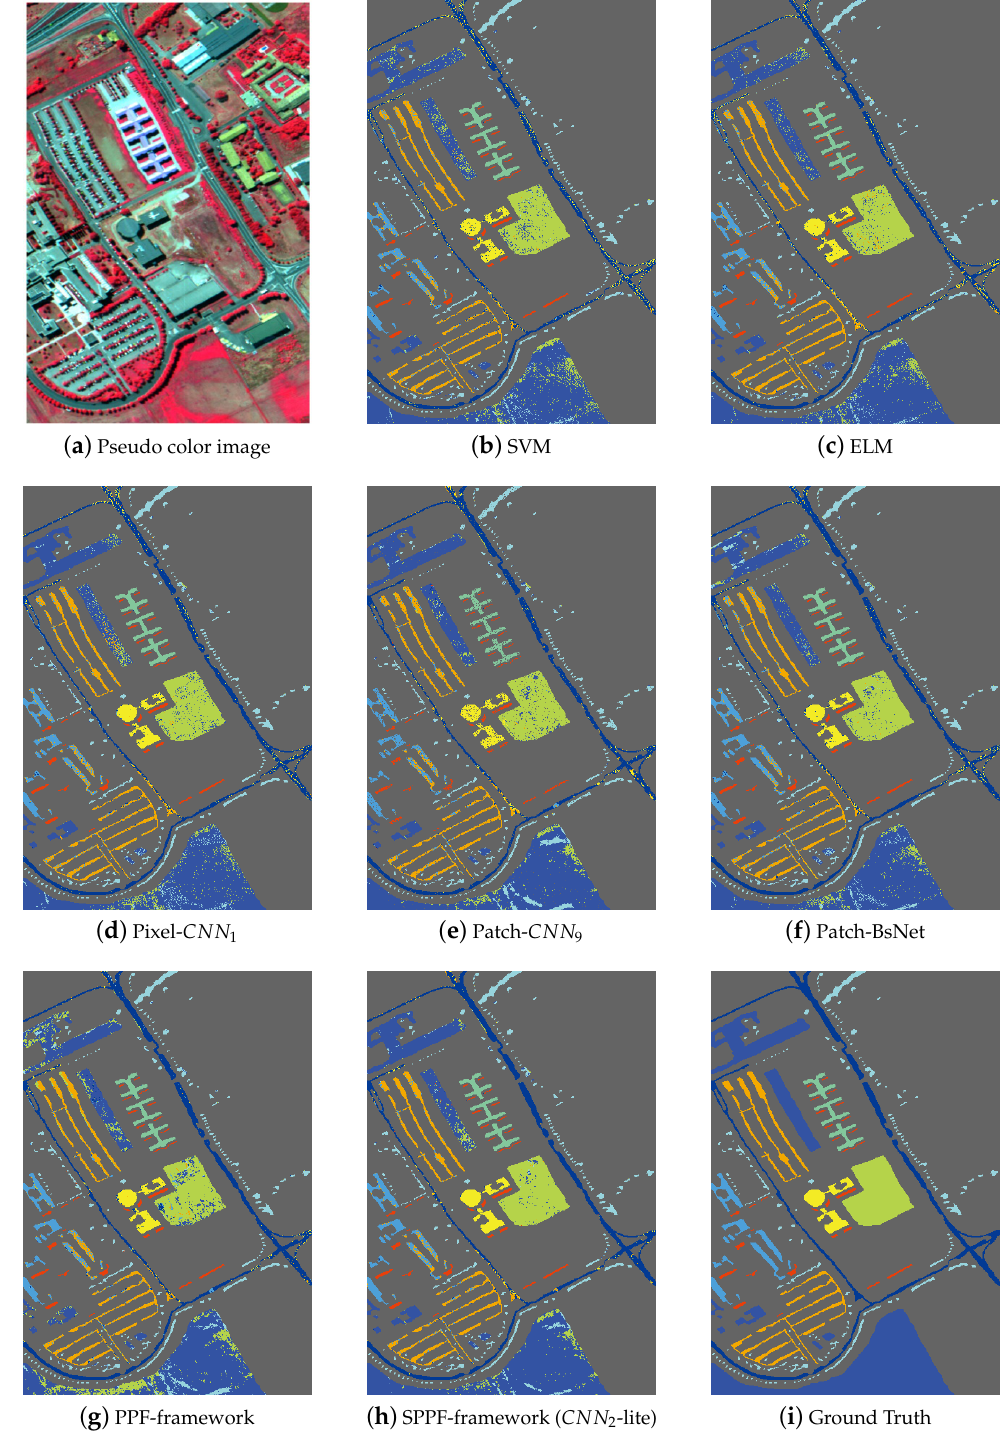
Figure 6. Results on the University of Pavia dataset. ( a ) Pseudo color image of the scene. ( b – h ) Results from competing methods. ( i ) The ground truth. Our algorithm achieves the best classification accuracy among the competing methods. (Best viewed in